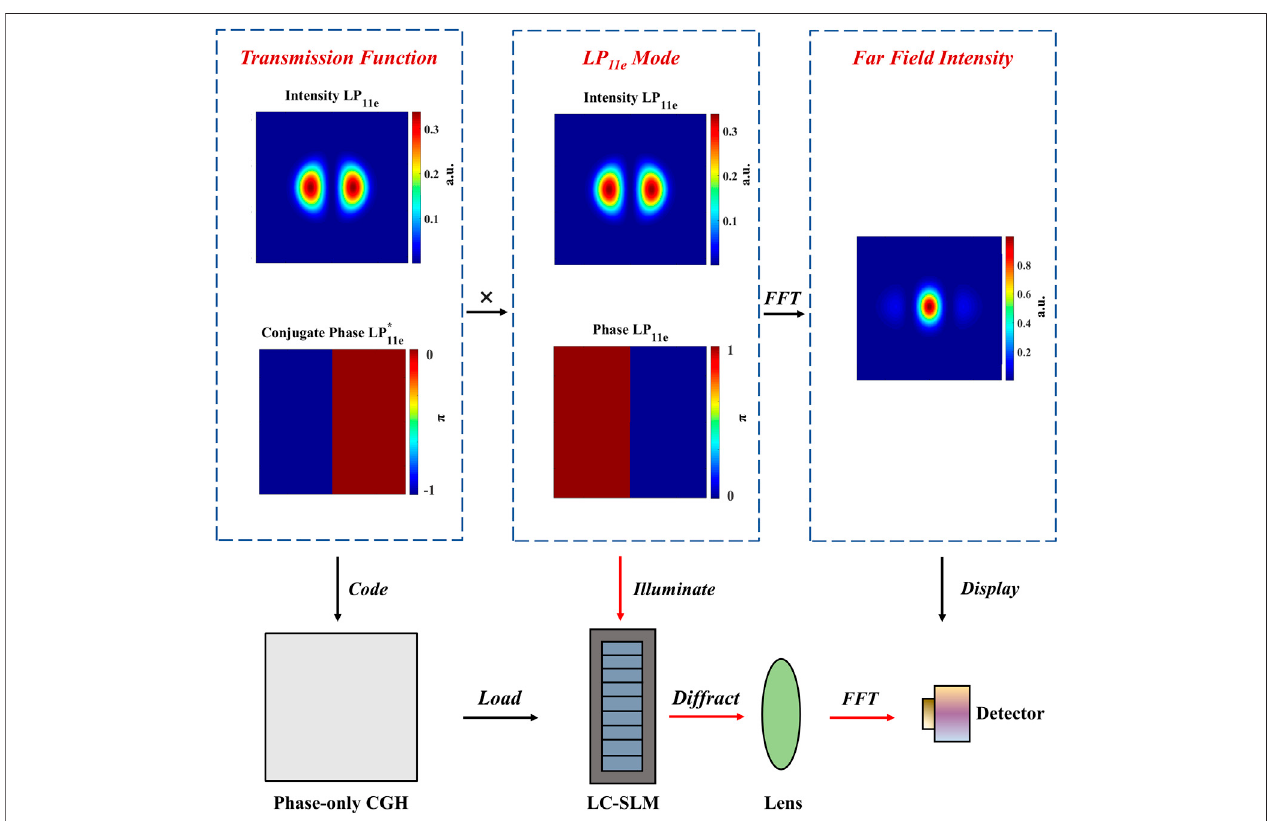
FIGURE 1 | A matched fi lter process for LP 11e mode via OCF method. For an ideal LP 11e mode, the peak intensity passes through the x-axis, and the image is perfectly symmetrical along the x (cid:2) 0 coordinate axis. The phase of the LP 11e mode is a 0- π step. When a LP 11e mode passes through a computer-generated hologram containing its conjugate phase (0-- π step), the light intensity in the far- fi eld Fourier plane will present the maximum value. FFT, fast Fourier transform.